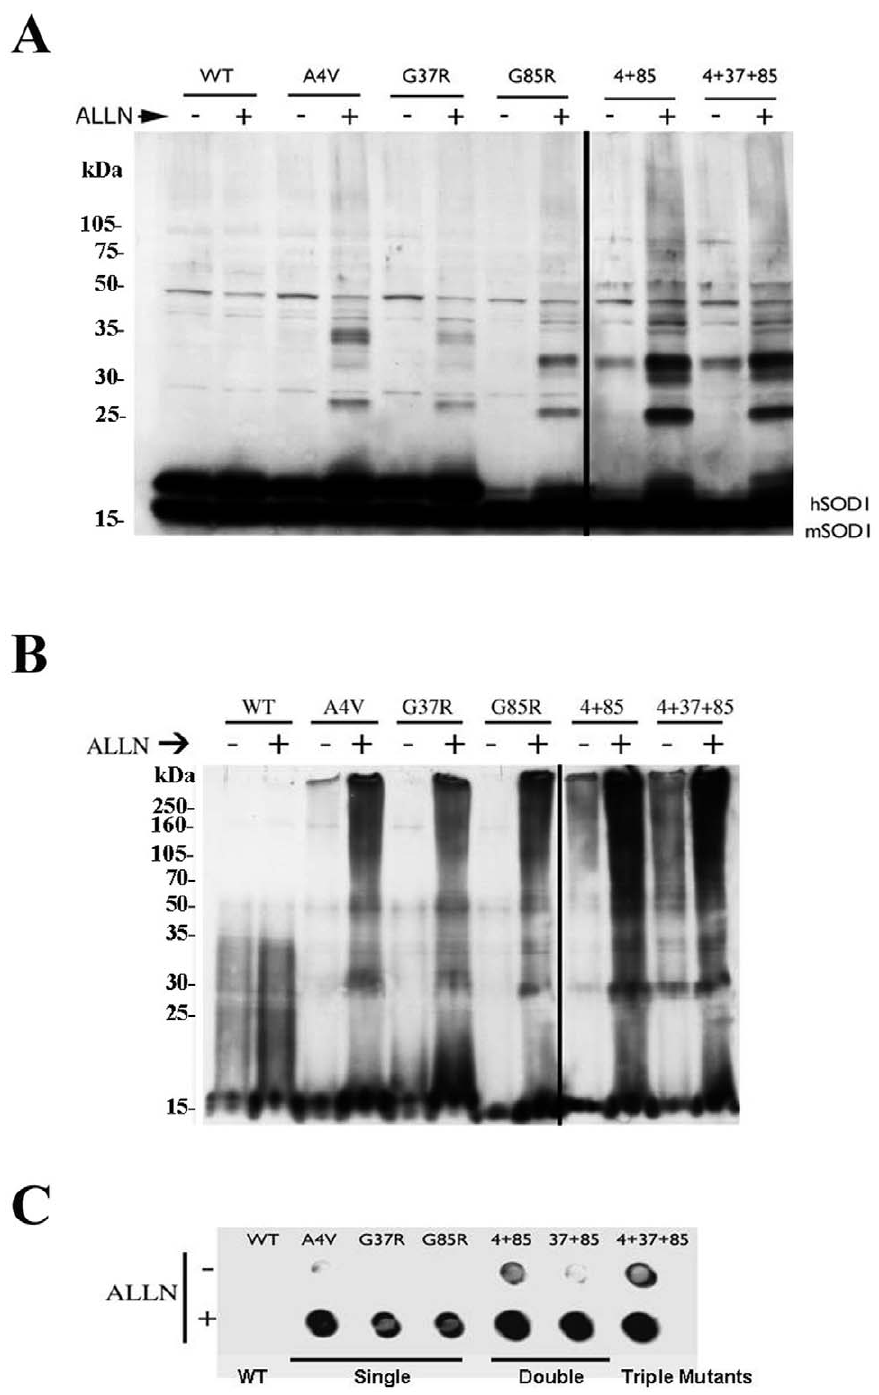
Figure 8. SOD1 with point mutations forms aggregates that are enhanced by proteasome inhibition. A. Western blot of WT and mutant SOD1 proteins run on a SDS gel. The antibody detects both the endogenous mouse SOD1 (mSOD1) and the expressed human SOD1 (hSOD1). B Western blot of WT and mutant SOD1 proteins run on a native gel. Antibody detects only the expressed human SOD1. C. Nitrocellulose filter assay of SOD1 to detect insoluble aggregates. As indicated, samples were incubated overnight with 10 m M proteasome inhibitor, (ALLN). doi:10.1371/journal.pone.0040329.g008 native gels, the proteins runanomalously due to charge and compatible with the data without this assumption (see Materials conformation. Therefore, the autocorrelation curves were also and Methods). Although this fit suggests that oligomer represent- fitted using a 2-component fitalong with the assumption that one sonly about 25% of the total Htt fragment pool with the rest being of the components was monomersince a 2-component fit was not monomer, but the size of the oligomer is approximately 8-fold